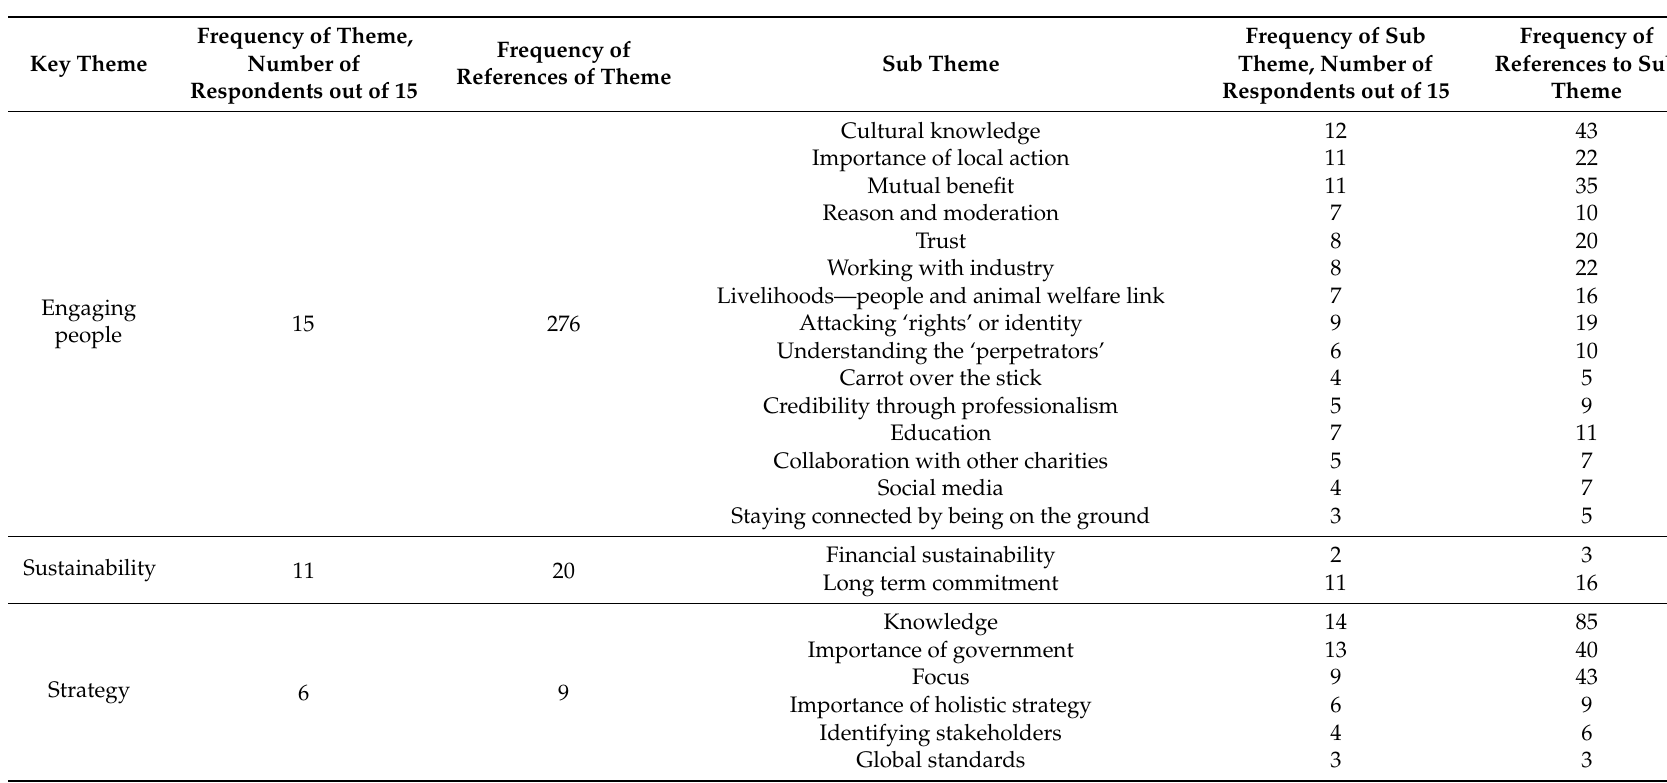
Table 2. Frequency of nodes identified to themes and subthemes as a proportion of total participants ( n = 15) and number of times the theme was mentioned, according to the attributed